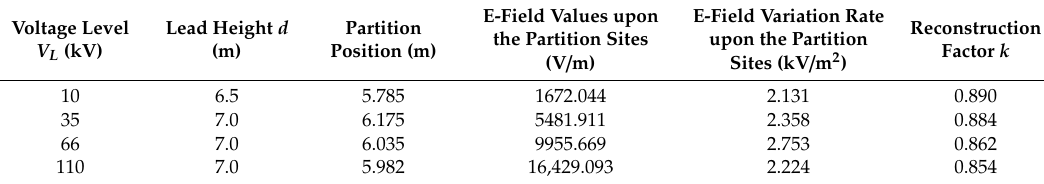
Table 3. The reconstruction factor and position parameters of overhead lines.